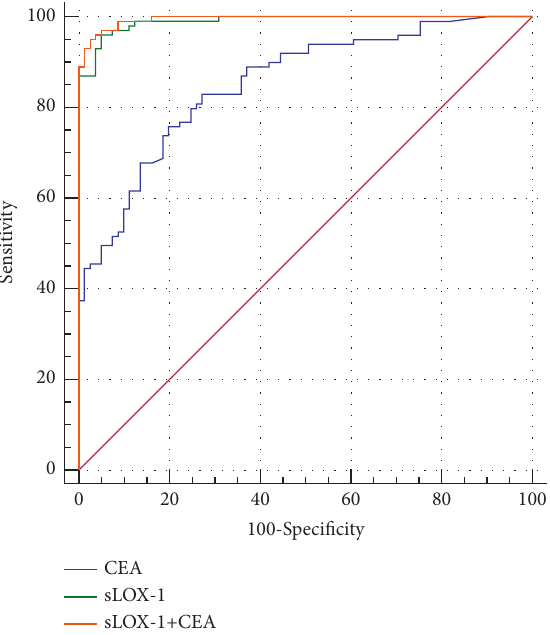
Figure 3: The diagnostic value of sLOX-1 and CEA single index and combination for